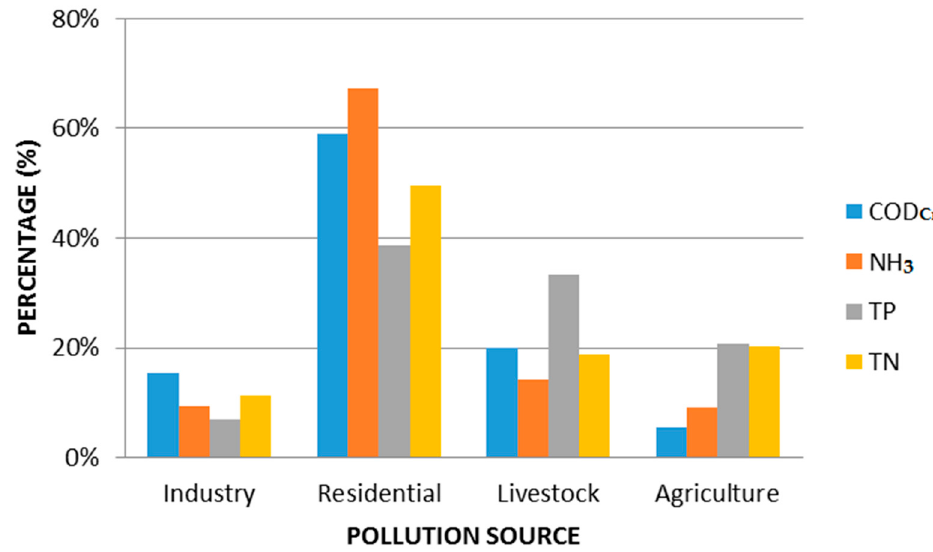
Figure 4. Contribution of different pollution sources in study area (2011–2013).